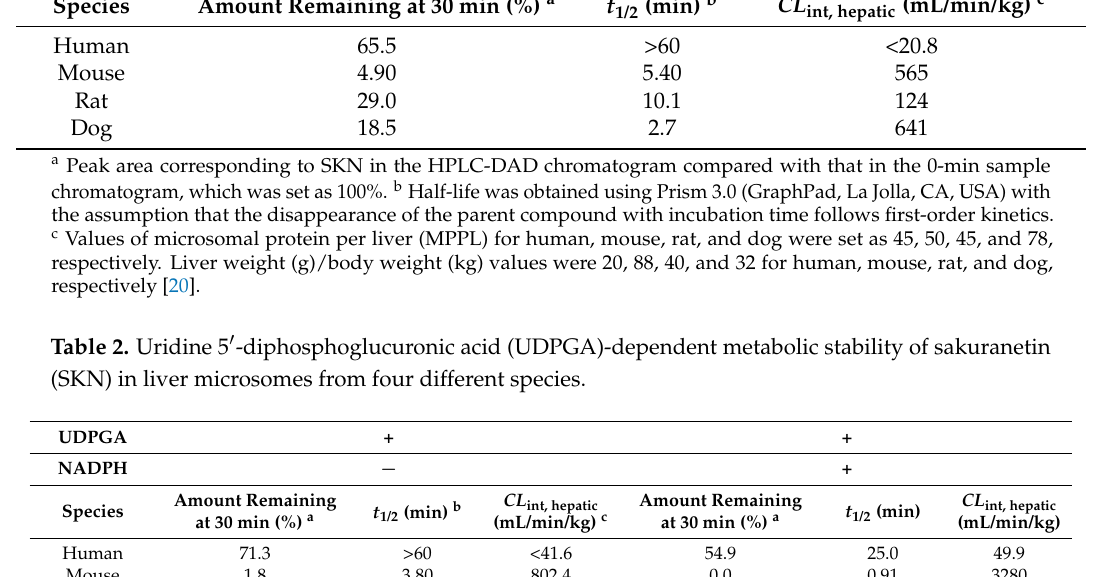
Table 1. NADPH-dependent phase I metabolic stability of sakuranetin (SKN) in liver microsomes from four different species. Species